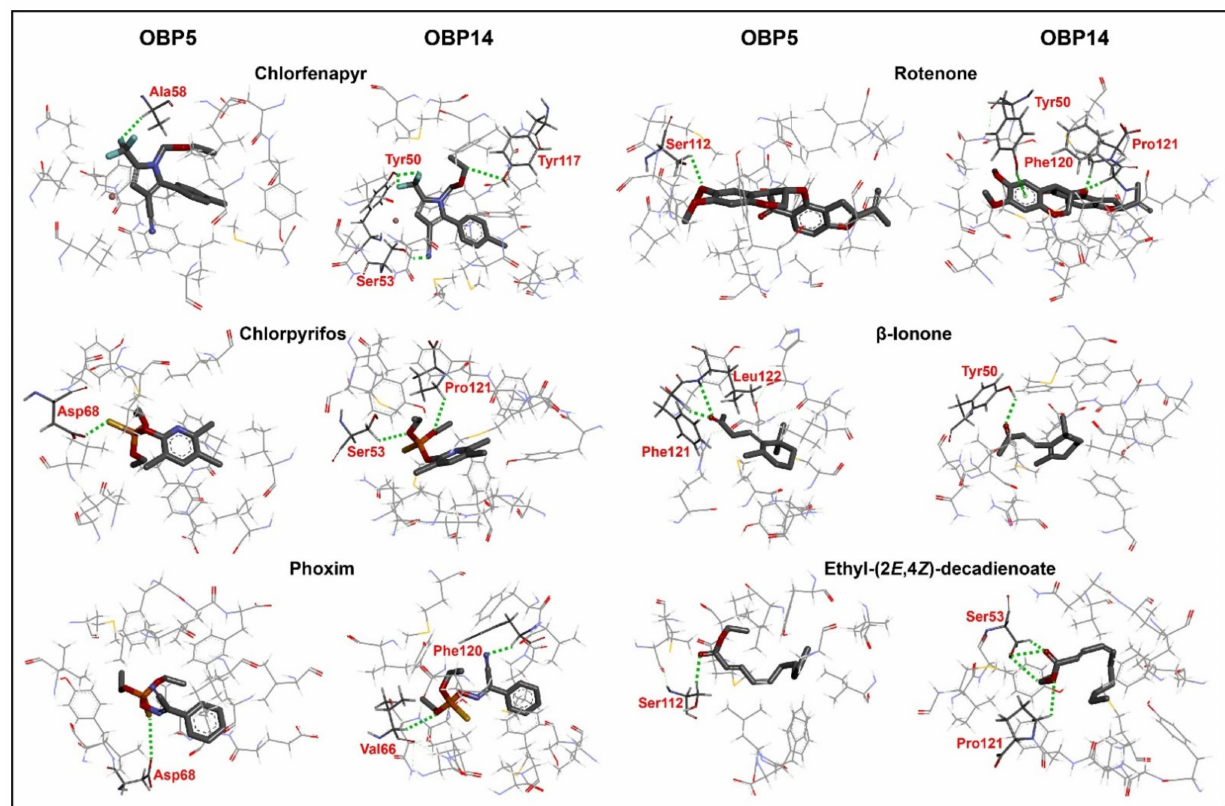
Figure 6. Molecular docking of DabiOBPs to six common ligands. Green dashed lines represent H–bonds between ligands and DabiOBPs. Residues forming inter-molecular H–bonds are shown in red. Detailed information on the interactions of ligands and proteins is listed in Table